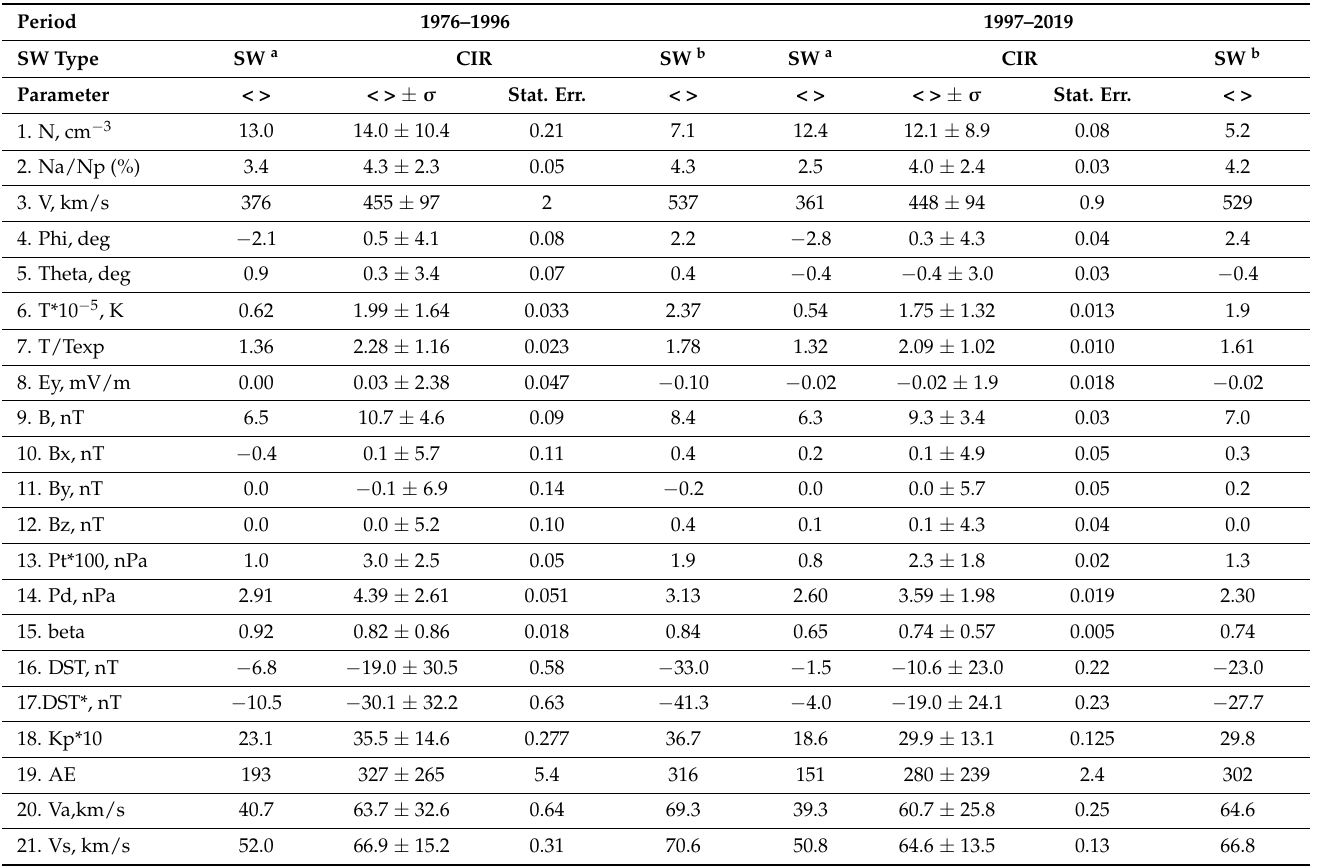
Table 2. Average parameters for sequence SW/IS/CIR/SW (Figure